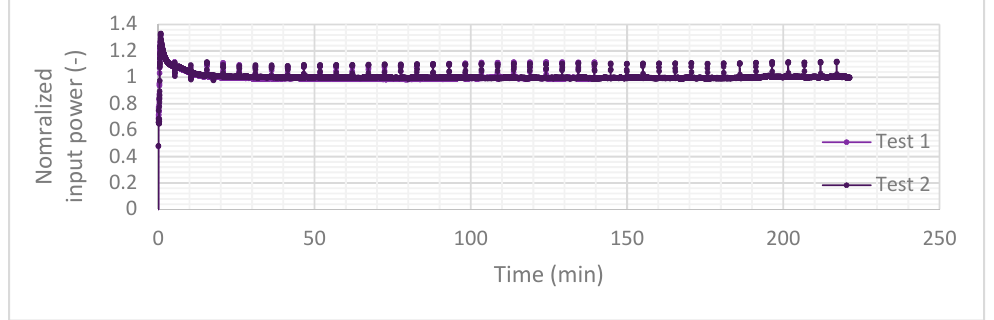
Figure A12. Normalized input power to the air compressor unit at the thermostatic temperature of − 30 °C.